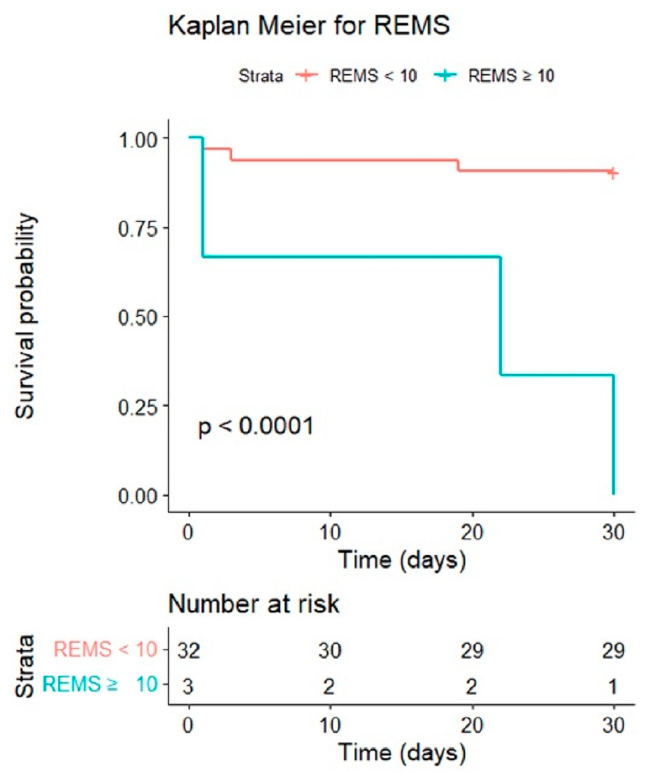
Figure 3. The cumulative survival rates of patients with EC were calculated to predict the 30-day mortality rate by Kaplan–Meier. The cut-off point of REMS was 10.